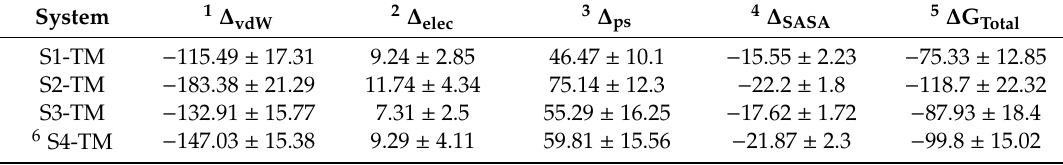
Table 4. Decomposition of the binding free energy (kJ mol − 1 ) between TM domains of TLR3.